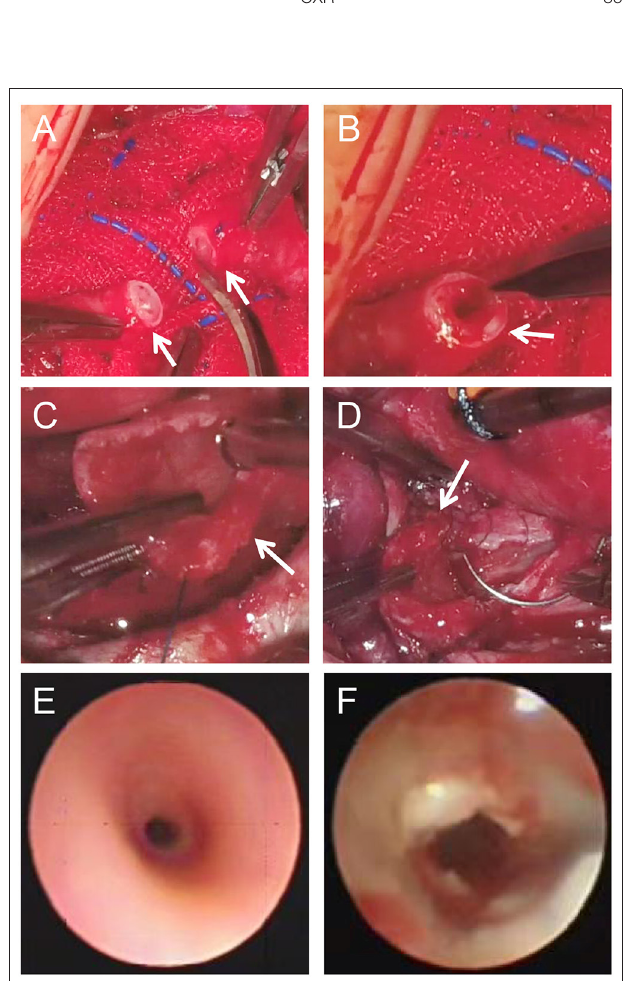
FIGURE 2 | Tracheal SLIDE operation (A–D) : Stenotic site was surgical resected (A, arrows), the upper (B, arrow) and lower part (C, arrow) were longitudinally extended and repaired by SLIDE anastomosis (D, arrow). Representative images of surgically treated trachea [before (E) and after (F) ].